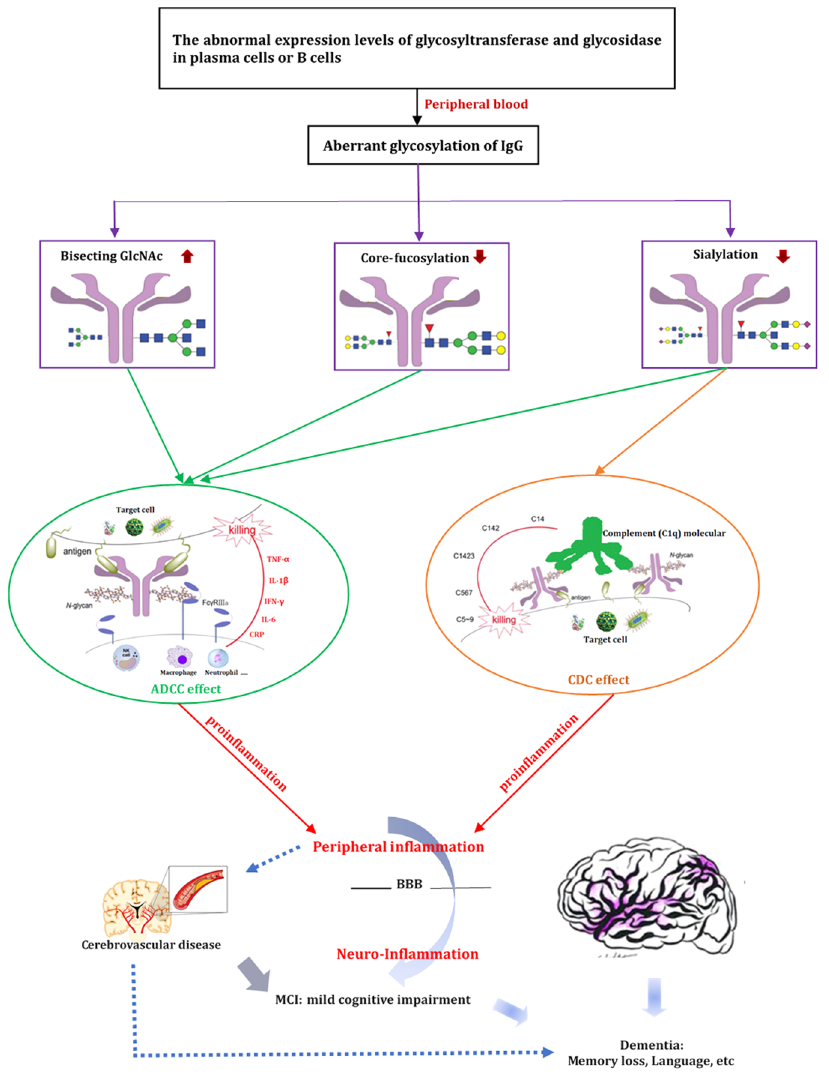
Fig. 6 The proposed roles of IgG N -glycans in the pathogenesis of dementia. The genetic or environmental factors may in fl uence the abnormal expression of glycosyltransferase and glycosidase in plasma cells or B cells. The decreasing sialylation and core fucosylation as well as increasing the bisecting GlcNAc contents within the Fc domain of IgG could activate its antibody-dependent cell mediated cytotoxicity (ADCC) by reducing inhibition to ligate Fc γ -RIIIa on natural killer (NK) cells, macrophage, and neutrophil which could release proin fl ammatory factors (such as IL-1 β , IL-6, CRP, TNF- α , and IFN- γ ). Decreased IgG Fc sialylation could reduce its complement-dependent cytotoxicity (CDC) activity via C1q binding, which could lead to increase activation of the lectin-initiated complement pathway. These changes of the IgG N